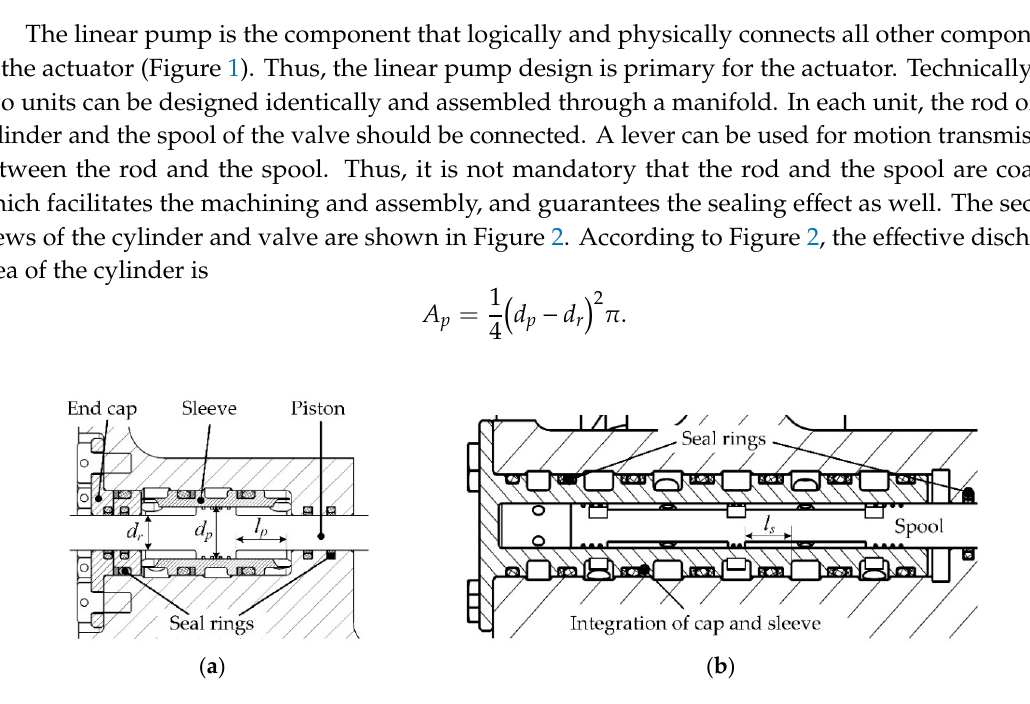
Figure 2. Section views of the linear pump components: ( a ) section view of the cylinder; ( b ) section view of the valve.